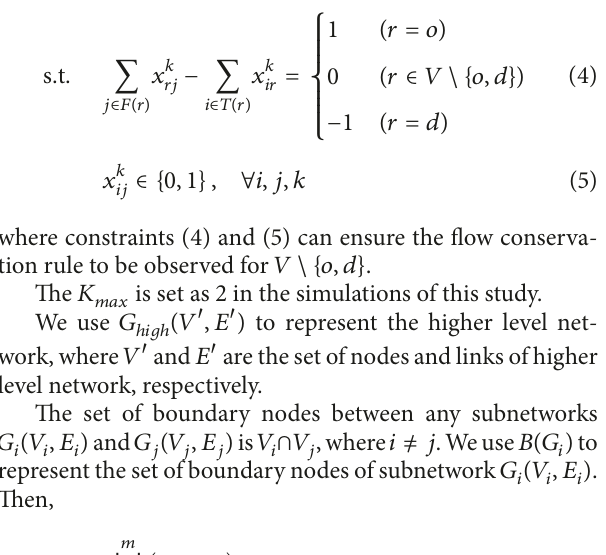
Figure 1: An example of Multilevel